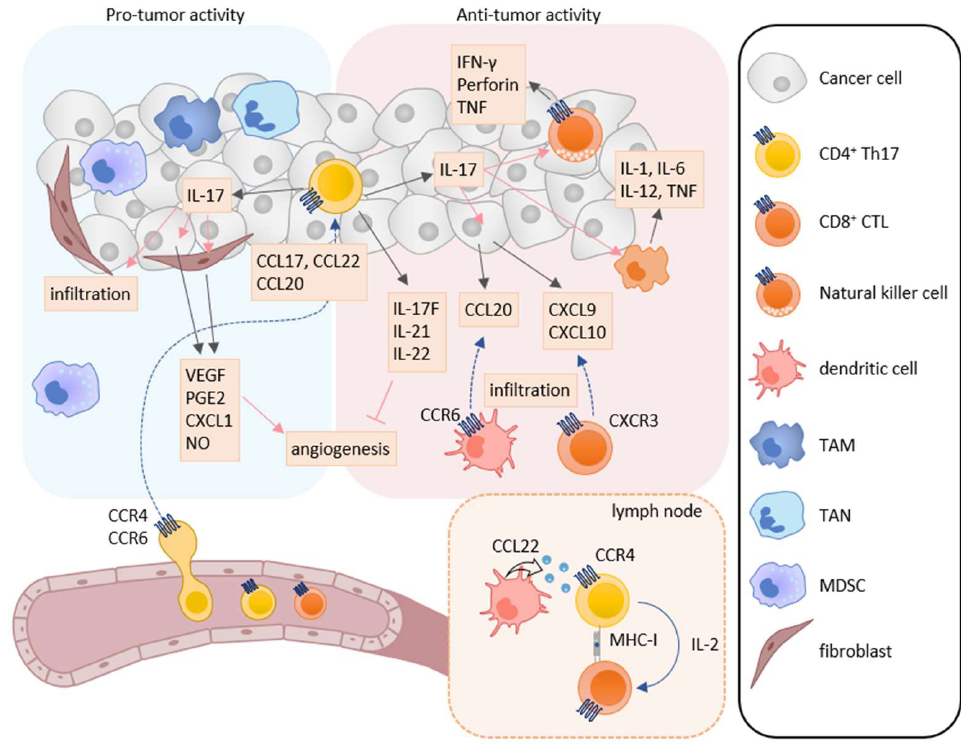
Figure 2. Roles of Th17 cells in tumor immunity. Th17 cells have both pro-tumor and anti-tumor activities in tumor immunity. IL-17A induces the production of angiogenic factors such as VEGF, PGE2, CXCL1, and NO from tumor cells and fibroblasts, leading to increase in angiogenesis. IL-17A also enhances the infiltration of MDSCs into tumor tissues. On the other hand, Th17 cells can directly induce tumor-specific CTLs via IL-2 production and MHC class I molecule expression in the lymph node. IL-17A also induces NK cells to express natural cytotoxicity receptor, perforin, TNF, and IFN- γ , and macrophages to express IL-1, IL-6, IL-12, and TNF. Furthermore, IL-17A induces the production of CXCL9 and CXCL10 in tumor cells and CCL20 in macrophages. These chemokines recruit CXCR3-expressing CTLs and CCR6-expressing immature DCs, respectively. In addition, IL-17F, IL-21, and IL-22 inhibit